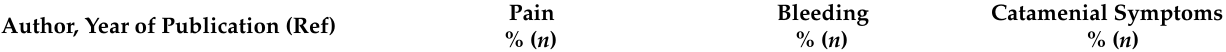
Table 3. Clinical symptoms of